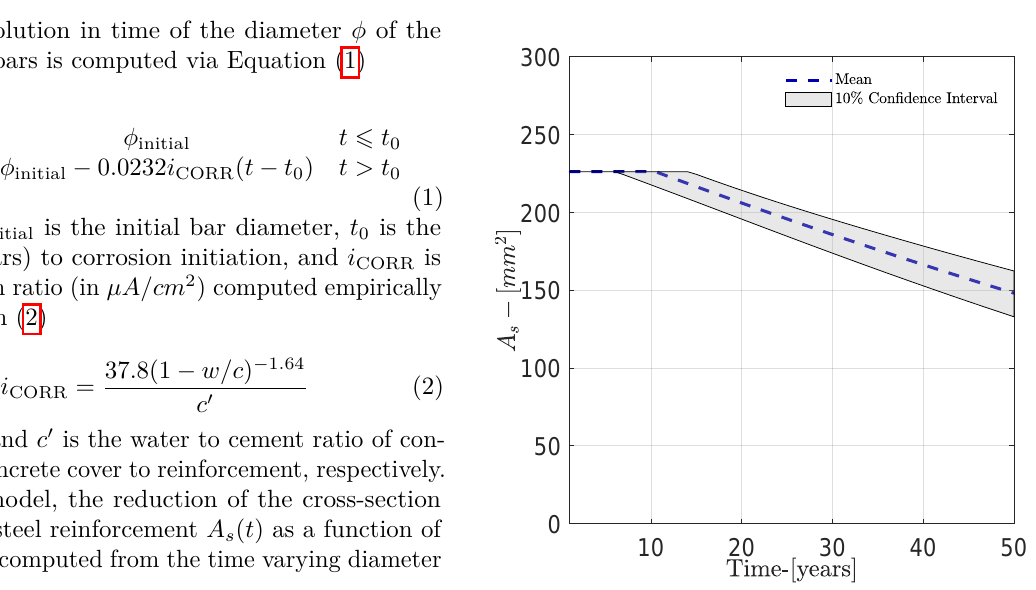
Figure 1. Uncertainty quantification of deterioration of steel cross-sectional area in the RC beam over its